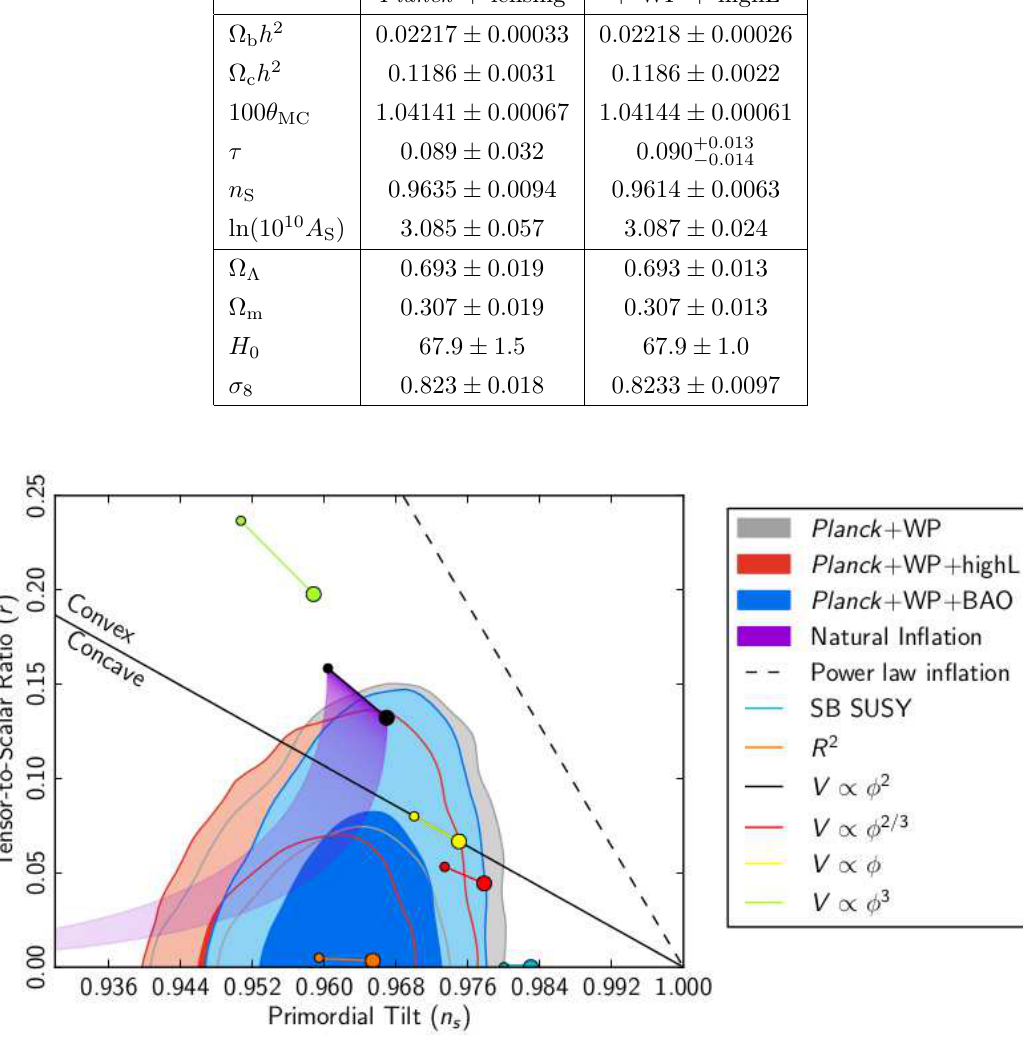
Figure 3: Marginalized joint 68% and 95% confidence level regions for n S and r from Planck in combination with other data sets, compared to the theoretical predictions of some inflationary models. Taken from Planck Collaboration XXII